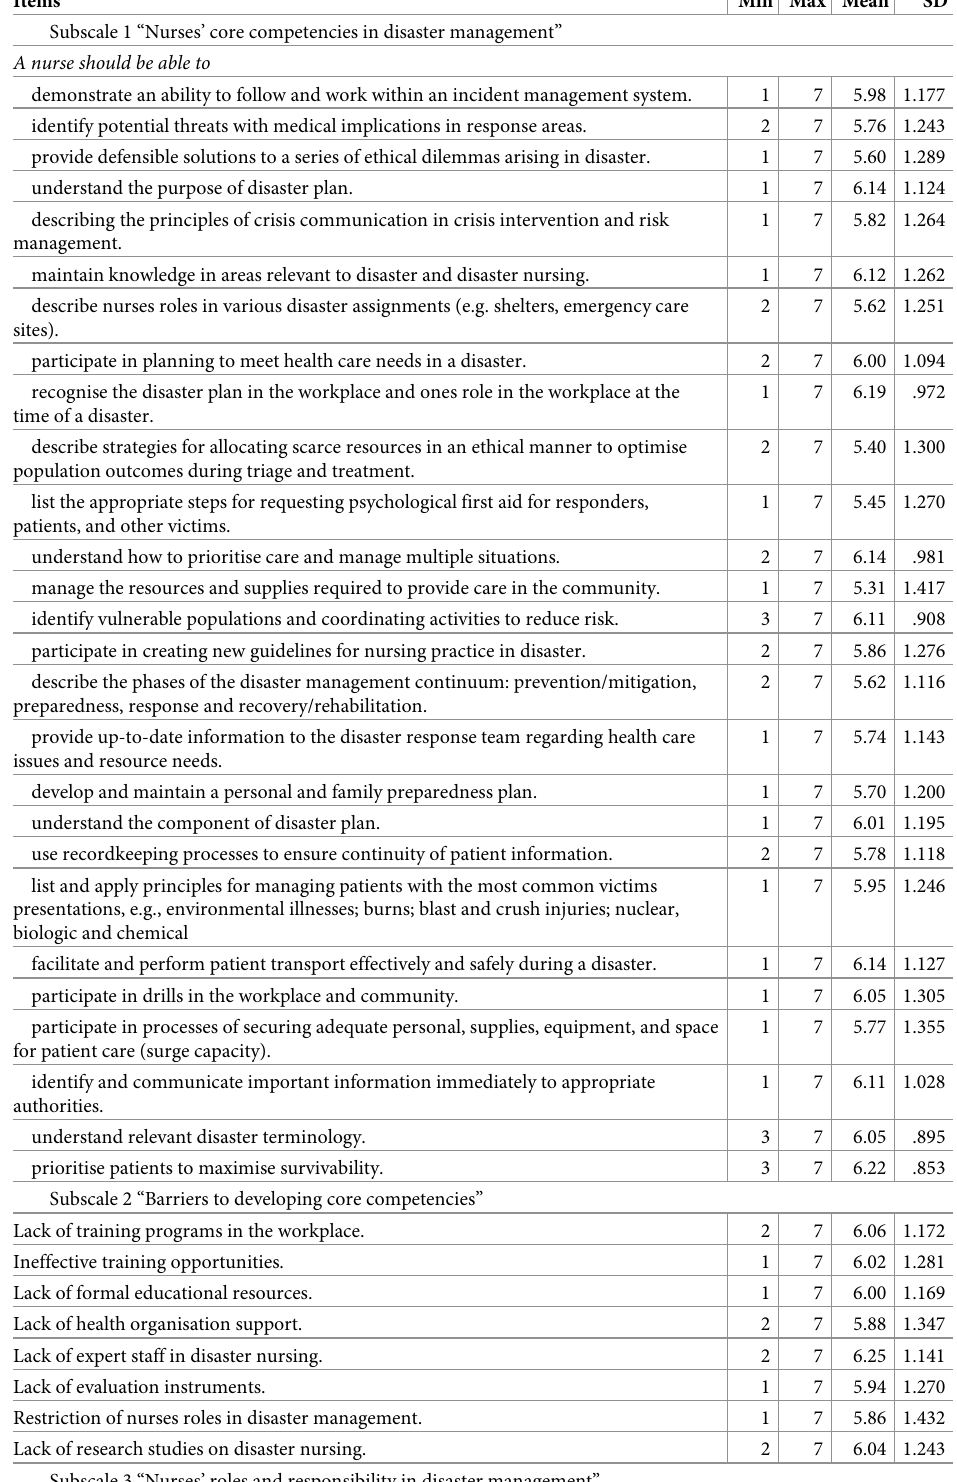
Table 2. Sl-Disaster Nursing Core Competencies Scale (n = 118)–descriptive